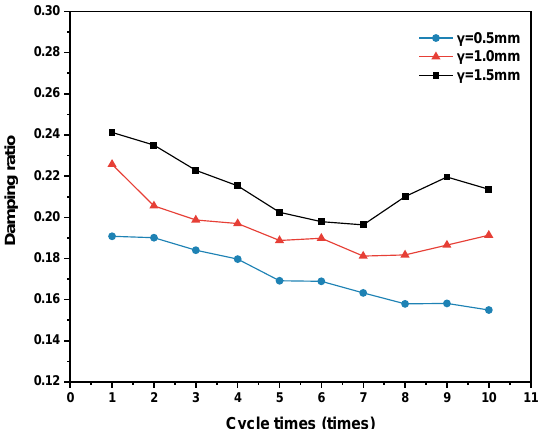
Figure 19. Development trends of damping ratios with different shear amplitudes. As can be seen from Figure 17, the hysteresis loop curve gradually develops from a regular ellipse to an S-shape when the shear displacement amplitude increases from 0.5 mm to 1.5 mm, and the areas of the hysteresis loop and the peak shear stress increase accordingly. The reason for this phenomenon is that as the shear displacement amplitude increases, the soil particles near the polymer – silty clay interface become more orderly and